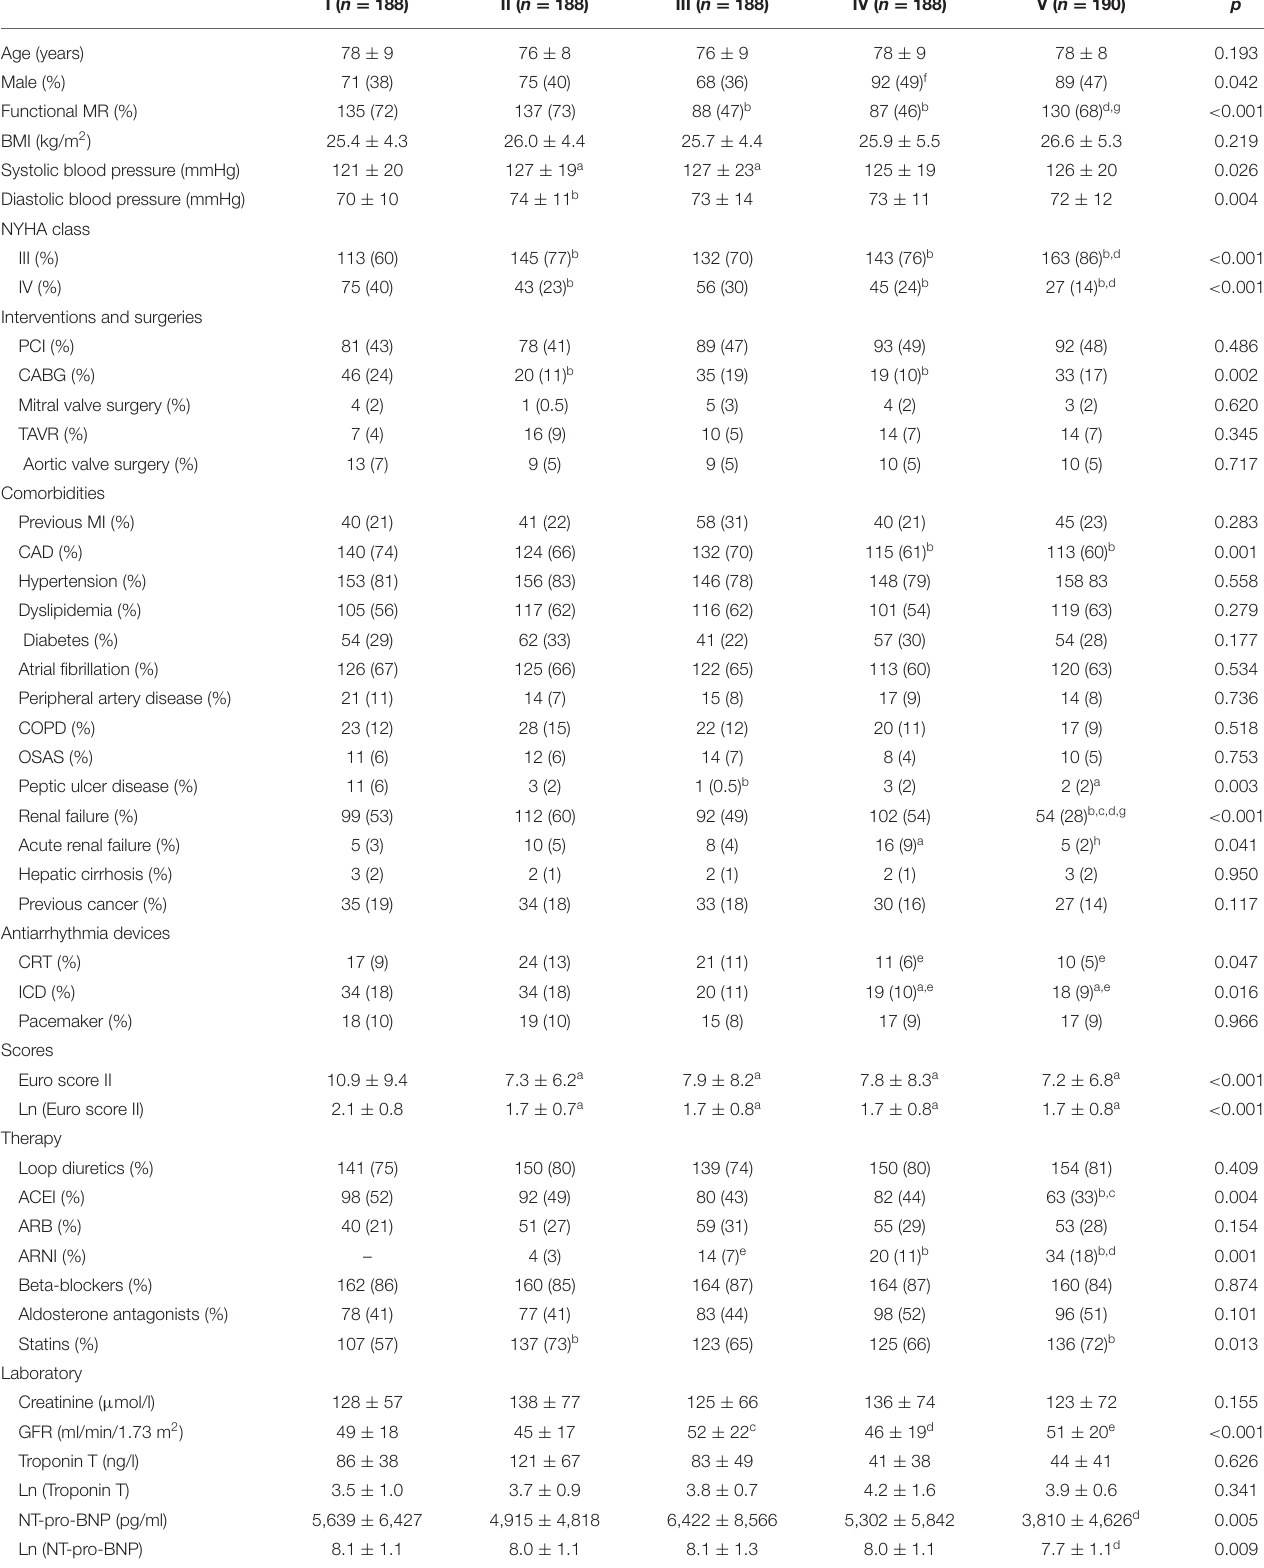
TABLE 3 | Demographic characteristics and clinical parameters in period between 2010 and 2021 separated in